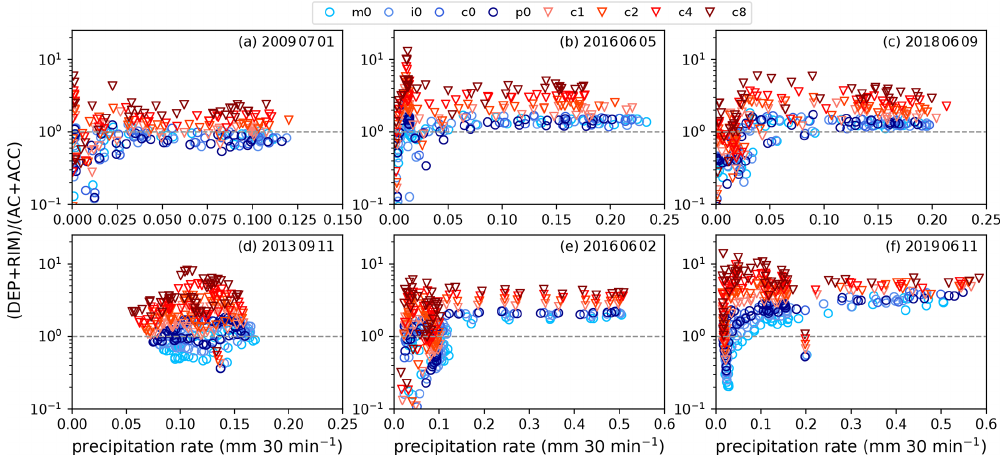
Figure 11. Ratio of cold-rain formation (deposition DEP and riming RIM) to warm-rain formation (autoconversion AC and accretion ACC) for weak synoptic forcing (a–c) and strong synoptic forcing (d–f) as a function of mean precipitation rate. Note the different abscissa ranges.